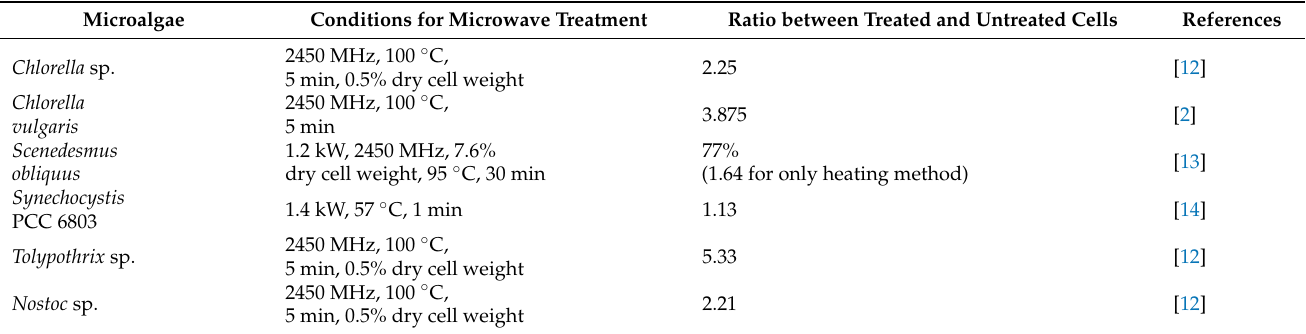
Table 1. Influence of microwave treatment on the oil yield for individual species of microalgae [8].